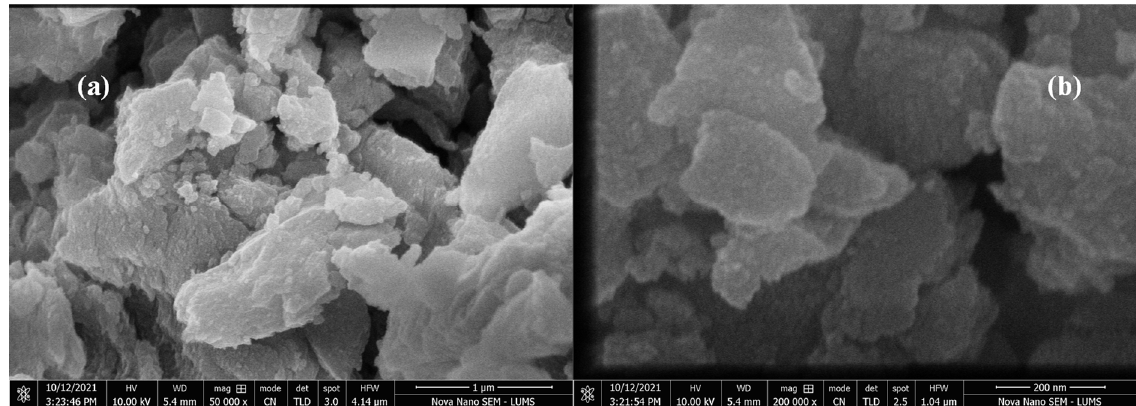
Figure 6. SEM micrographs of Fe/Mn NPs at 1 µm ( a ), 200 nm ( b ).